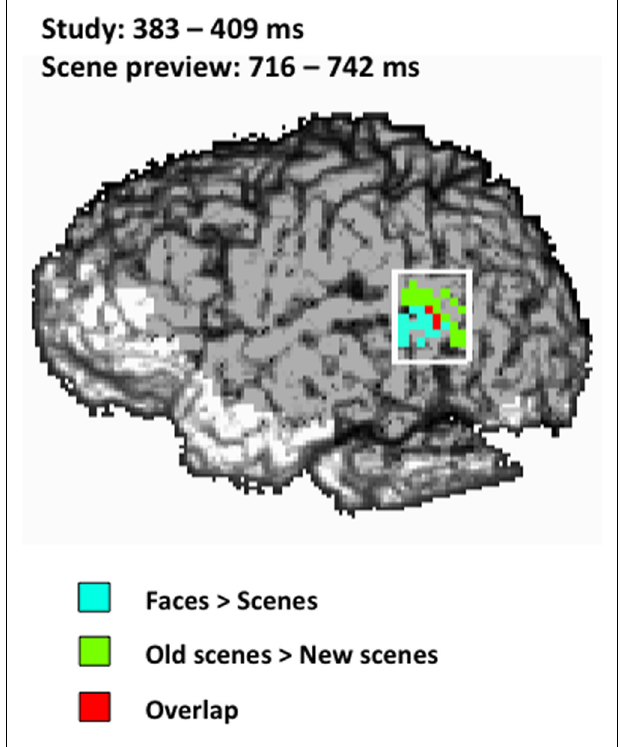
FIGURE 5 | Spatial map of the conjunction analysis projected onto the left sagittal surface at a threshold of p < 0.04 for the conjunction ( p < 0.2 for each condition separately). Blue represents the activity for faces > scenes from 383–409 ms during study, green represents the activity for old scenes > new scenes from 716–742 ms during the scene preview, and red represents the overlap between those two activations. The white rectangle indicates the STS